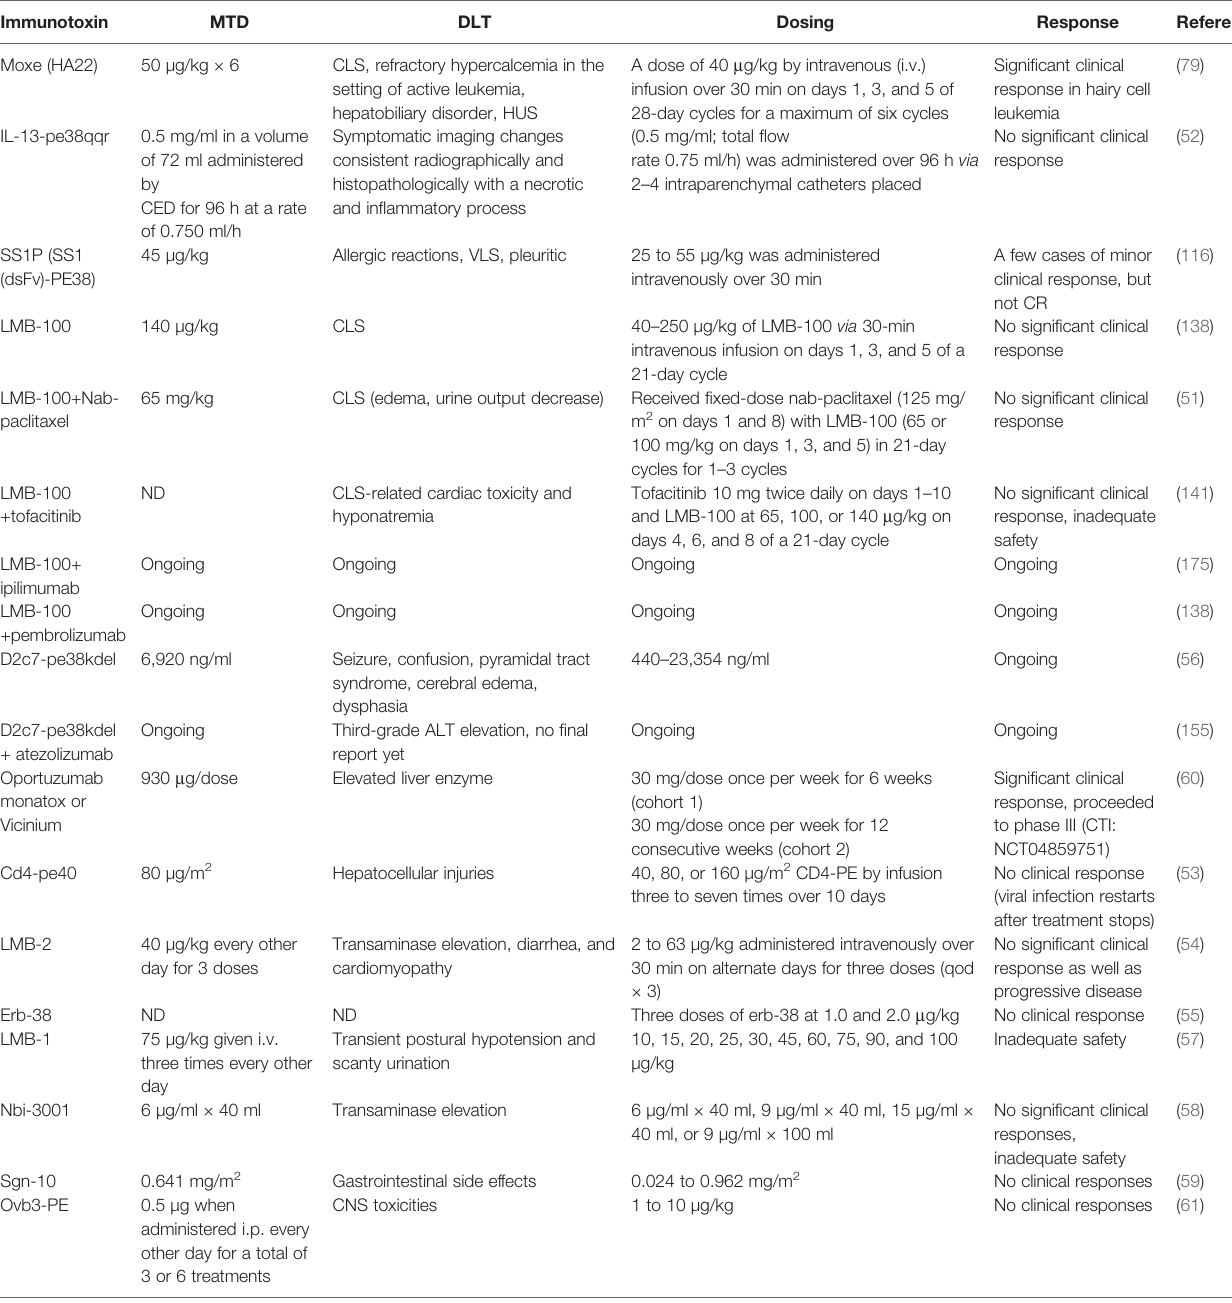
TABLE 3 | Clinical characteristics of PE – ITs advanced to clinical trials, alone or in combination with other therapeutic